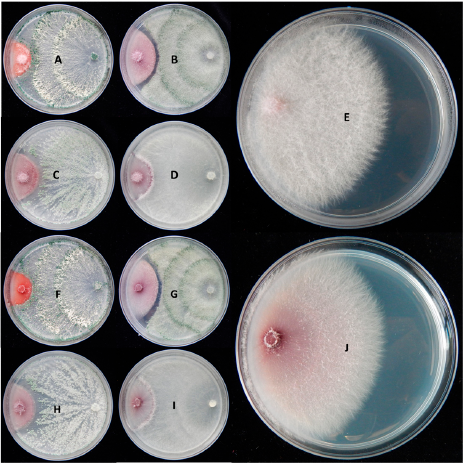
Figure 2. Dual culture tests between F. circinatum FcCa1 ( A – E ) and Fc015 ( F – J ). ( A , F )— T. asperellum T20; ( B , G )— T. virens T21; ( C , H )— T. hamatum T3; ( B , I )— T harzianum T6; ( E )—control culture of FcCa1; ( J )—control culture of